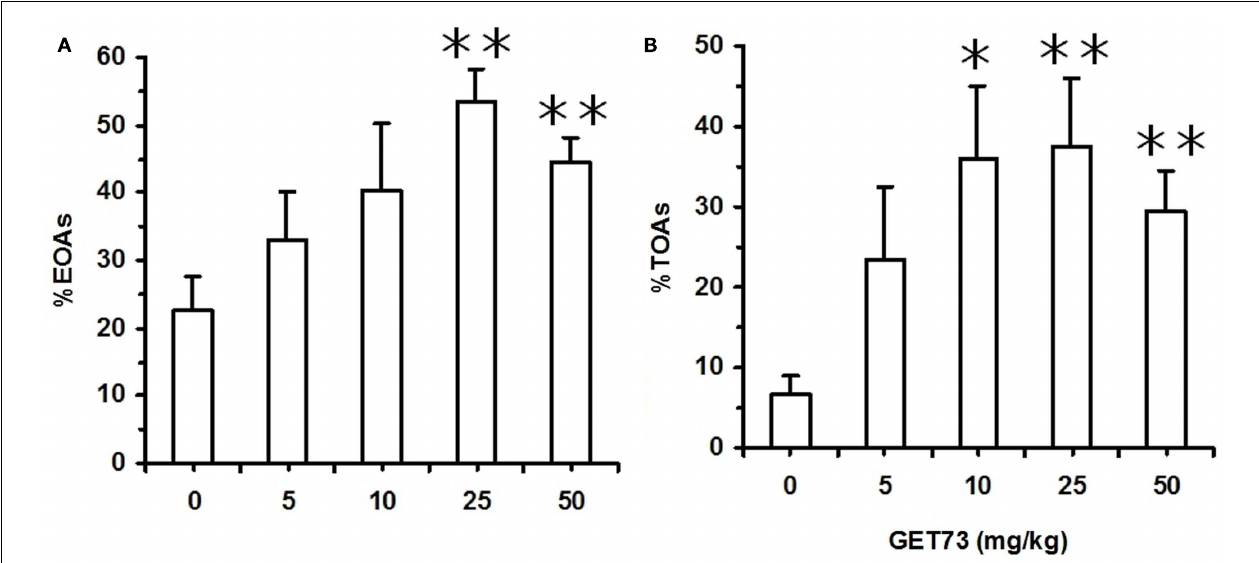
plus maze (EPM) test. GET73 was administered 30min before the EPM test. Exposure to the EPM lasted for 5min. Entry into a given arm was scored once the rat had all four paws in that arm. Each bar is the mean ± SEM of n = 4–7. * P < 0.05 and ** P < 0.01 with respect to 0-mg/kg GET73-treated rat group (Kruskal–Wallis and Mann–Whitney